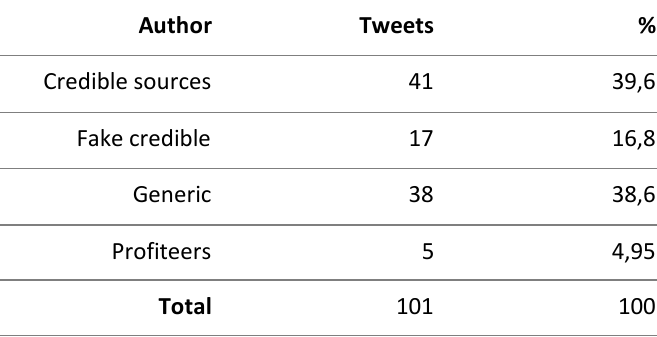
Table 1. Number of tweets containing misinformation by author